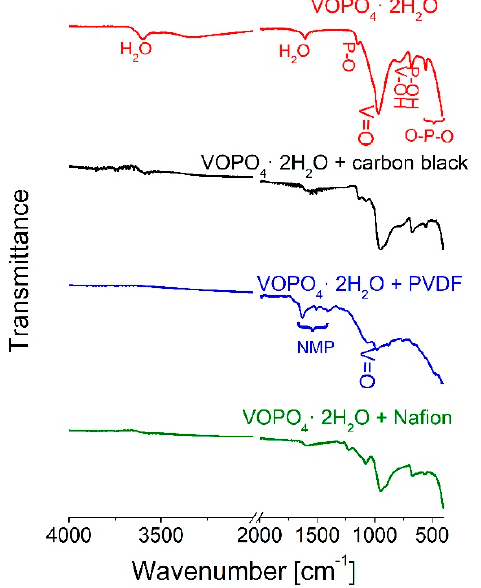
Figure 5. Comparison of FTIR spectra of the VOPO 4 ∙ 2H 2 O and its mixtures with carbon black, carbon black and PVDF, and carbon black and Nafion.